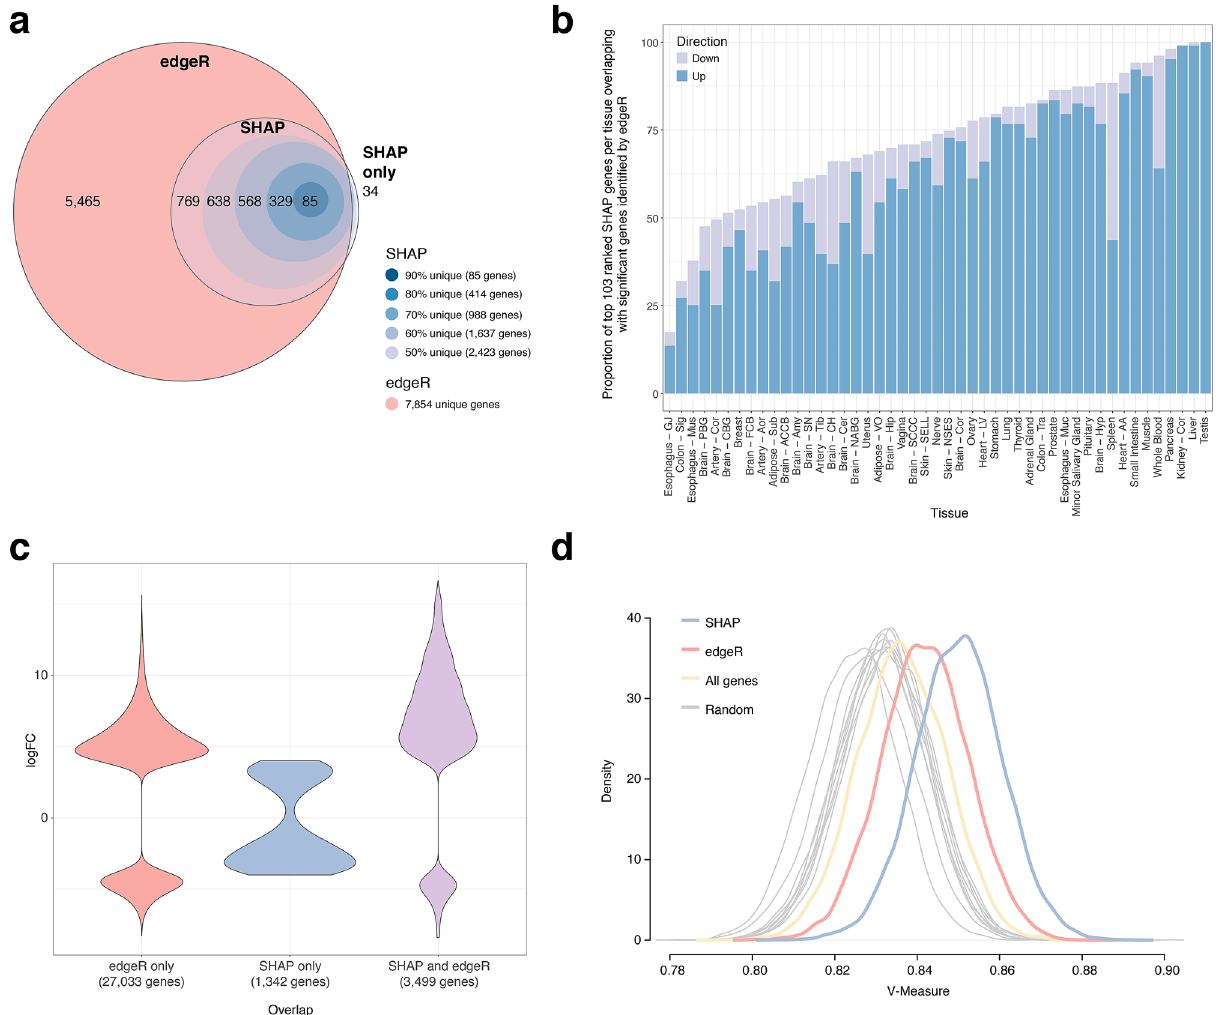
Figure 4. Comparison of the most salient genes from the Convolutional neural network (CNN) model according to SHapley Additive exPlanations (SHAP) and the significant genes from edgeR. ( a ) Euler diagram comparing the unique sets of gene lists from edgeR (7,854 genes) and SHAP, where the outermost circle for SHAP represents the unique genes from top 103 ranks (2,423 genes; 50% unique), and the circles within, from largest to smallest, represent the unique genes from the top 58 (1,637 genes; 60% unique), 30 (988 genes; 70% unique), 11 (414 genes; 80% unique) and 2 (85 genes; 90% unique) ranks, respectively. ( b ) The proportion of the top 103 ranked genes according to SHAP that overlap with all significant edgeR genes per tissue. Direction of expression of each gene per tissue was obtained from edgeR analyses, where up (blue) represents genes with log2 Fold Change (logFC) > 4, and down (lilac) represents genes with logFC < -4. ( c ) Violin plots of the top genes unique and common to the edgeR and SHAP methods at the individual tissue level, showing logFC as determined by edgeR. Some genes are included more than once if they were identified in multiple tissues. The SHAP method identified 4841 top genes (top 103 ranked genes, 50% unique), and the edgeR method identified 30,532 significant genes. The SHAP and edgeR methods had 3499 genes in common ("SHAP and edgeR", purple). Thus, 30,532–3499 = 27,033 genes were unique to the edgeR method ("edgeR only", red) and 4841– 3,499 = 1342 genes were unique to the SHAP method ("SHAP only", blue). ( d ) V-Measure of k-means clustering analysis on Uniform Manifold Approximation and Projection (UMAP). k-means clustering was performed using SHAP genes (2423 genes), 10 random sets of 2423 genes, edgeR genes (7854 genes), and all genes (18,884